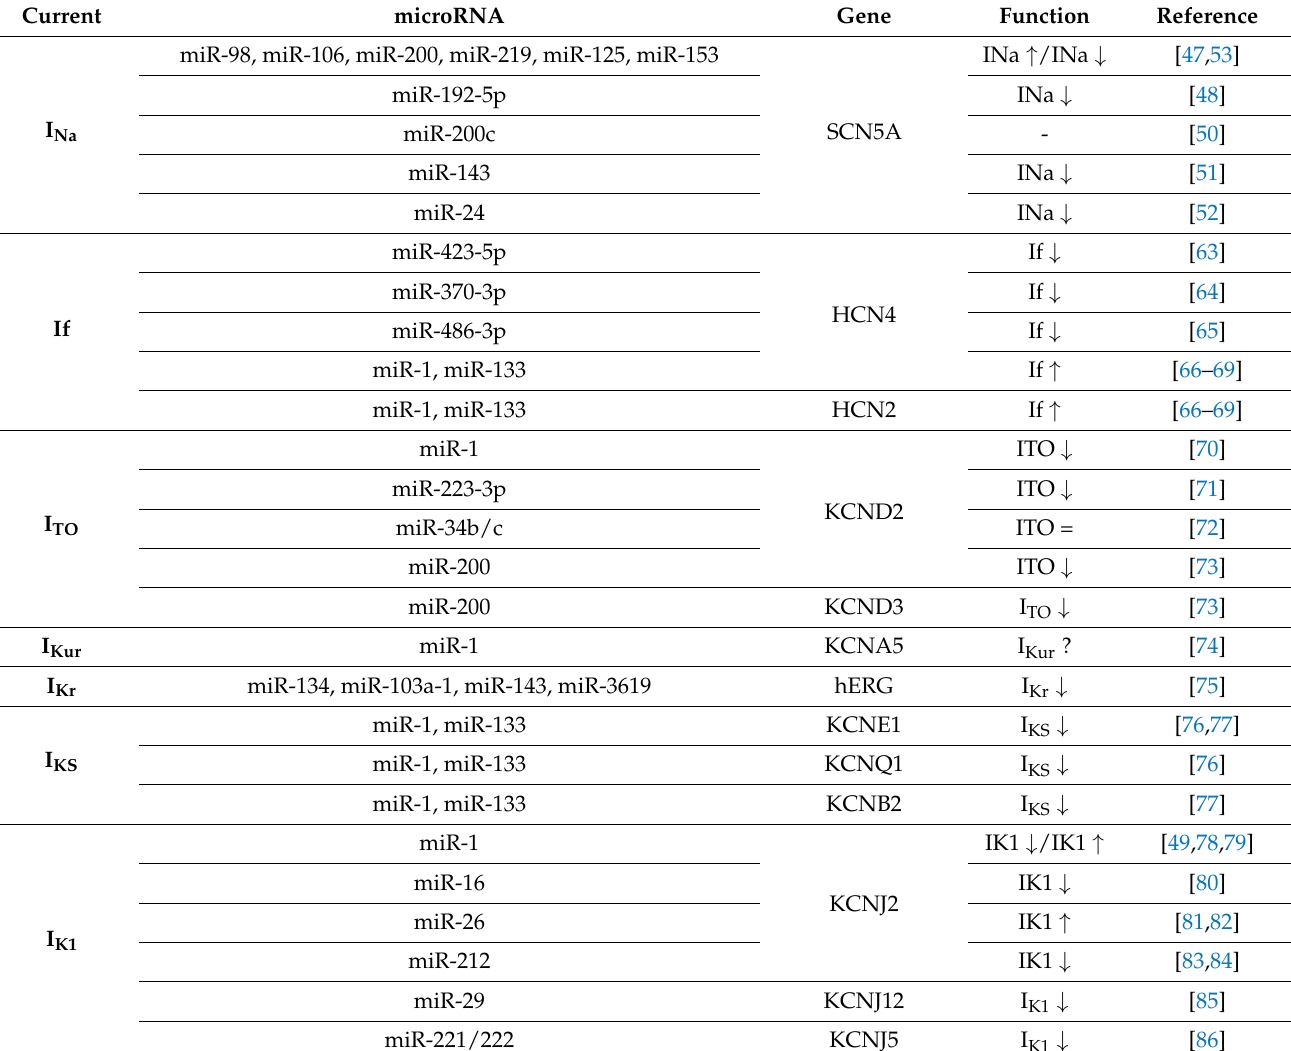
Table 1. List of microRNAs reported to modulate ion channel expression in the